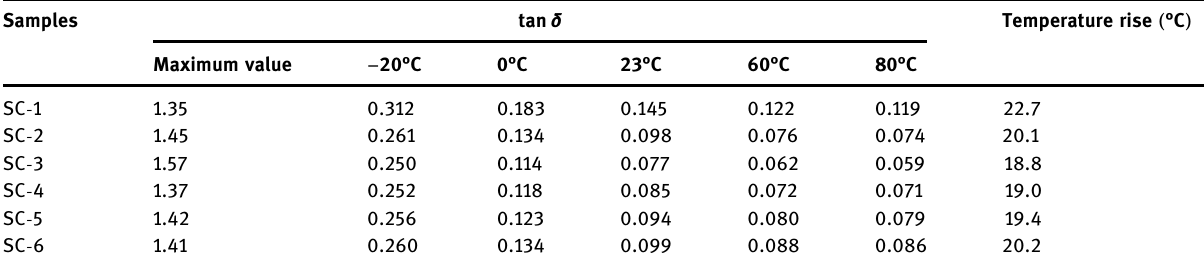
Table 4: Dynamic mechanical properties of modi fi ed IR/silica/CB vulcanizates with ATD Samples tan